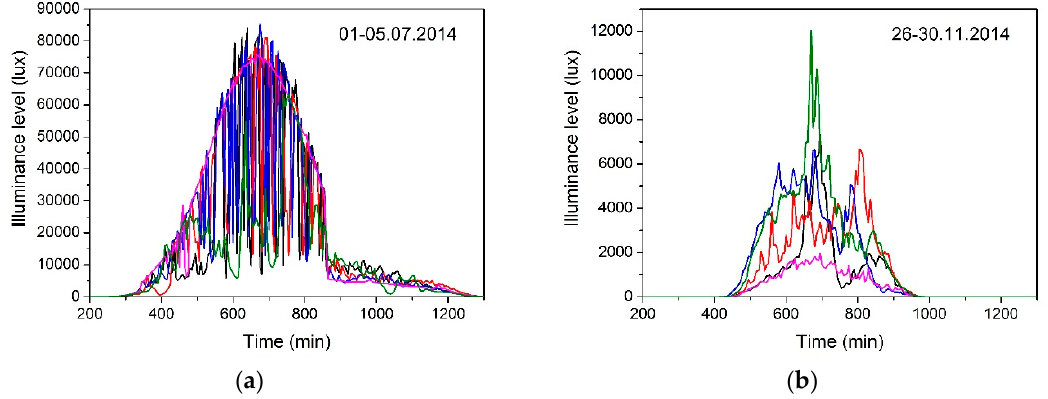
Figure 5. Daylight illuminance level recorded by the weather station mounted on the south-eastern facade of the building ( a ) from 1 July 2014 to 5 July 2014 and ( b ) from 26 November 2014 to 30 November 2014.